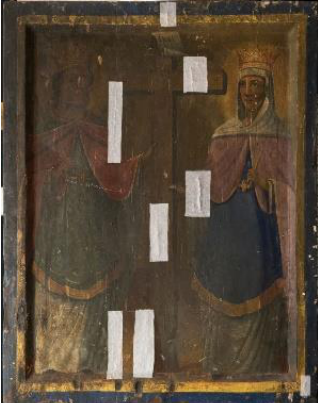
Figure 1. St. Constantine and Helen icon, painted on